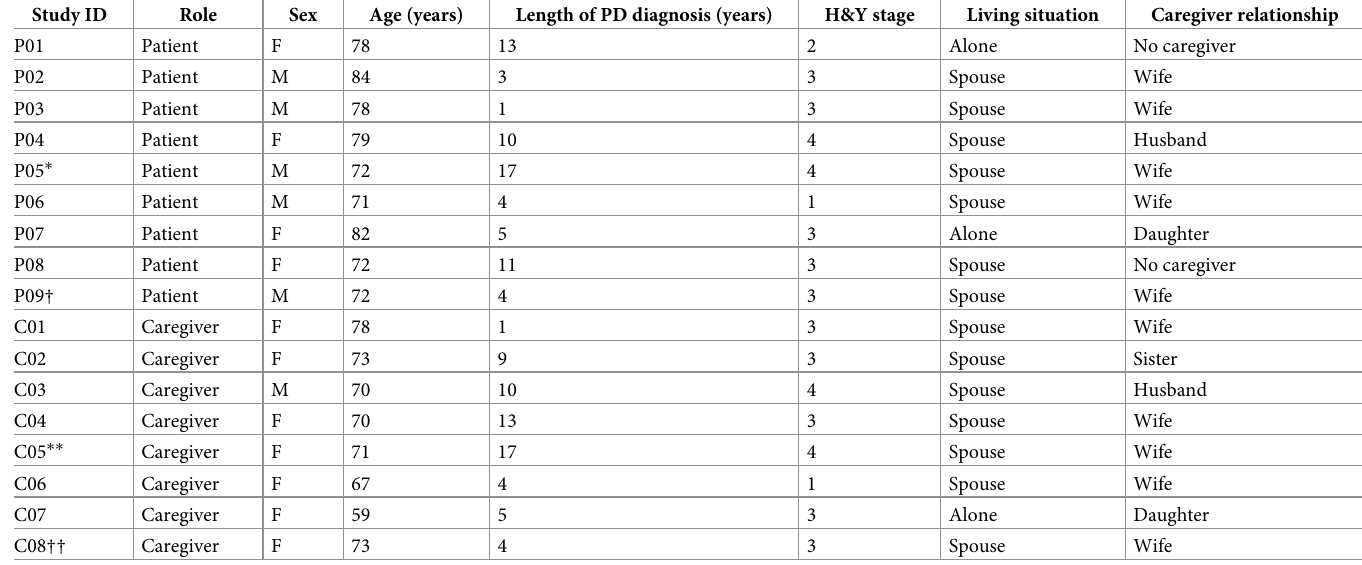
Table 1. Participants’